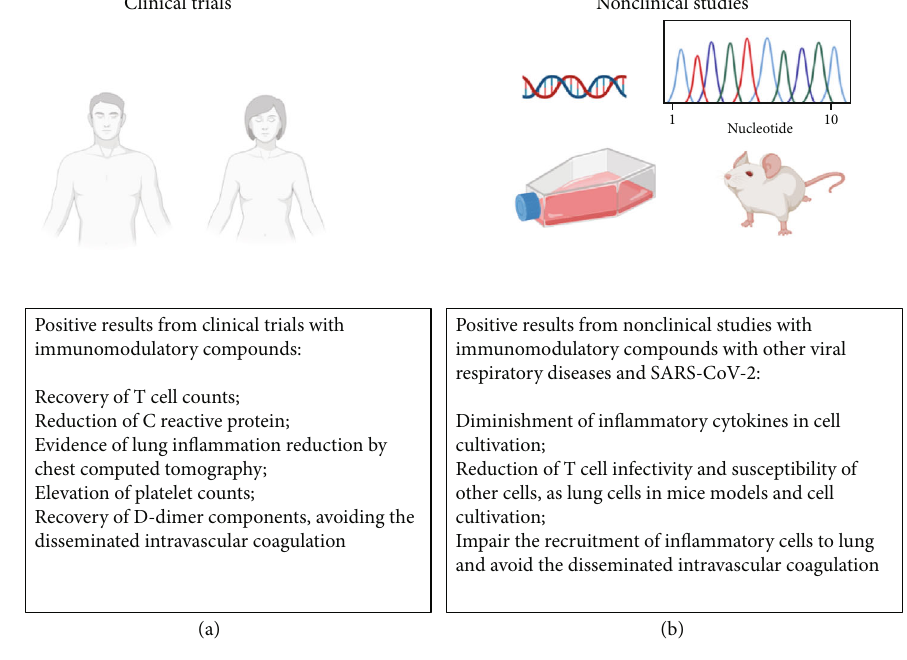
Figure 4: Good results of immunotherapies on clinical trials and nonclinical studies in the immune response against COVID-19. (a) Recent and preliminary positive fi ndings with clinical trials using immunotherapy for COVID-19 treatment are summarized focusing on immune event alterations and recovery, as well as in nonclinical studies (b) for immunotherapeutic interventions using bioinformatics tools, cell cultivation, and animal models; they are also based on past information with other related viral respiratory diseases and autoimmune disorders. Created with